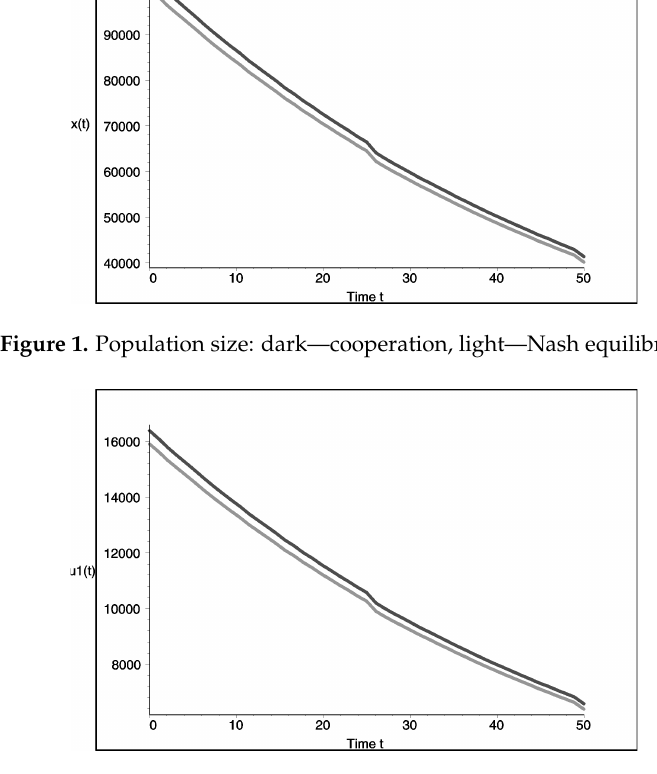
Figure 2. Player 1’s catch: dark—cooperation, light—Nash